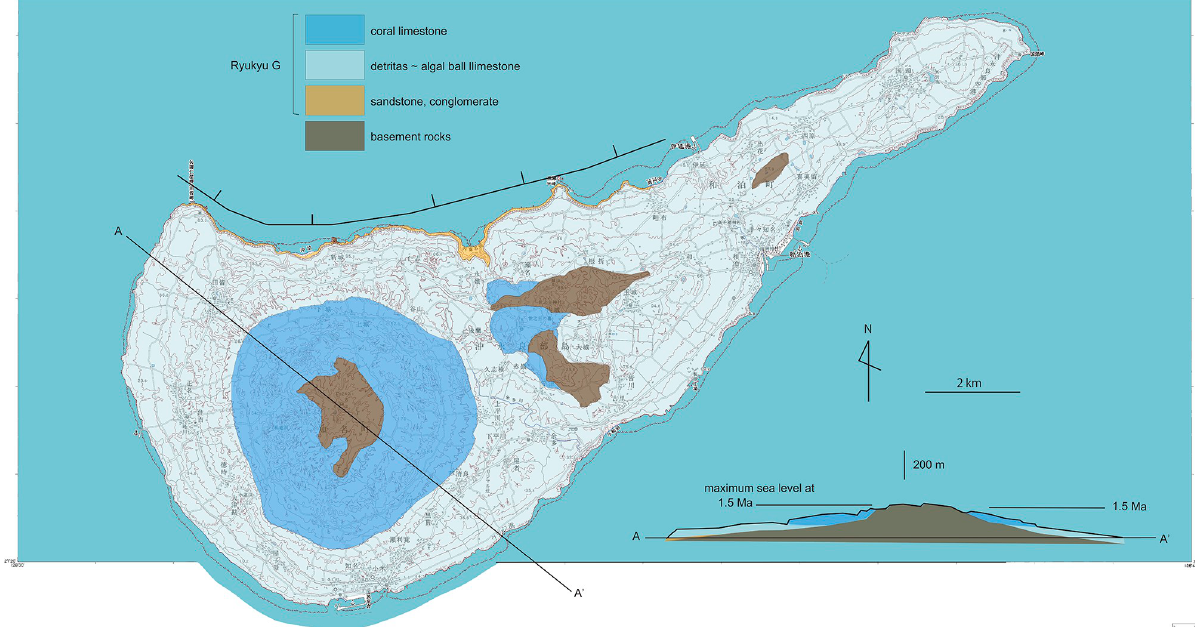
Fig 17. Geological map and cross section (below) of Okinoerabu-jima. A terrace developed on 1.5 Ma limestone. Uplifting was apparently slower compared to the examples of Toku-shima and Kikai-jima and has been progressed since 1.55 Ma. This history has resulted in a relatively wide coastal plain lacking high sea cliffs, except for fault scarp cliff at along the western part of northern margin. Miyako-jima and Ishigaki-jima have also only a single terrace in 1.5 Ma limestone, and northeastern end of Amami Oshima is also associated with 1.5 Ma limestone, whereas Okinawa-jima and Kume- jima have low elevatioon terraces developed with ca. 0.2 ~ 0.4 Ma (not dated) limestone. Background: Digital topographic maps of 1: 25,000 scale, the Geospatial Information Authority of